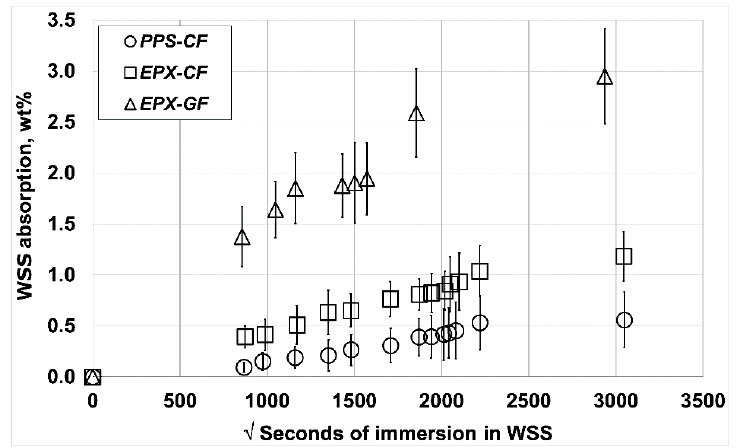
Figure 4. Water uptake plots (wt.%) for the tested laminates immersed in warmed WSS